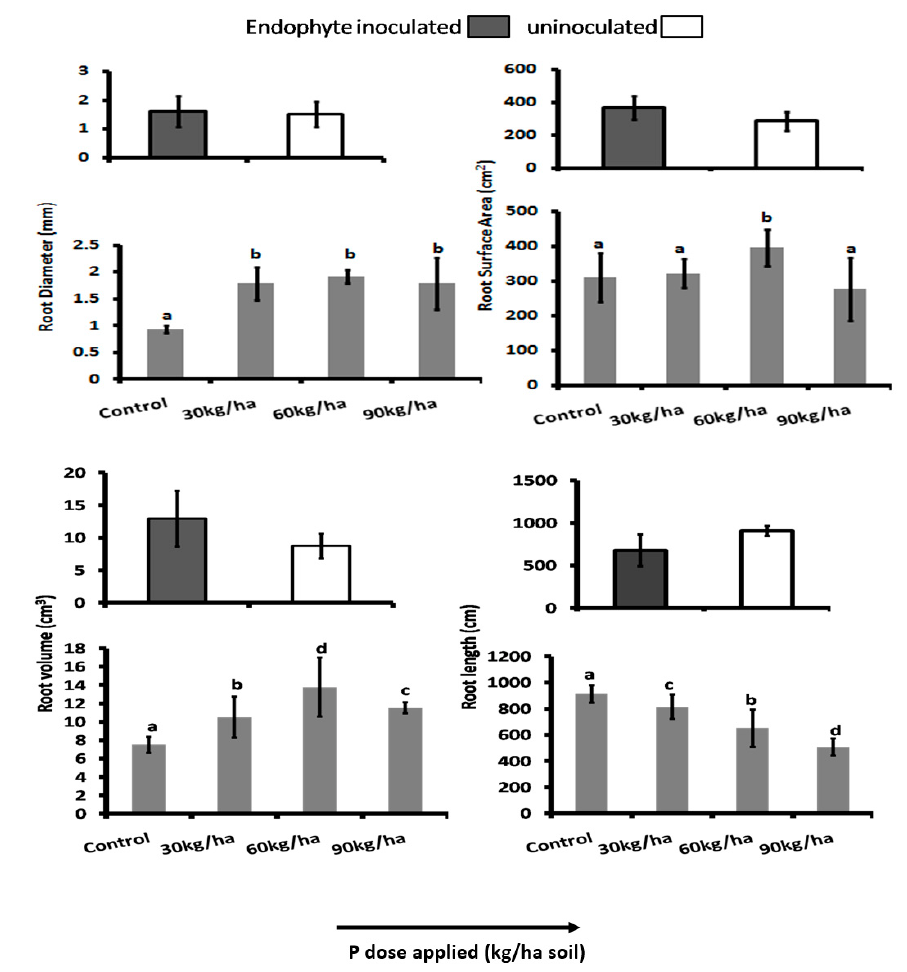
Fig. 4: Root morphological features: Root Diameter (RD) Root Surface Area (RSA), Root Volume (RV) and Root Length (RL) of the rice crop (CAUR3 var) grown under different P-doses and with and without inoculation. Statististical Analysis was performed by Two Way ANOVA followed by Turkey’s post hoc comparision with three replications using SPSS v.21 (SPSS Inc., Chicago, IL,